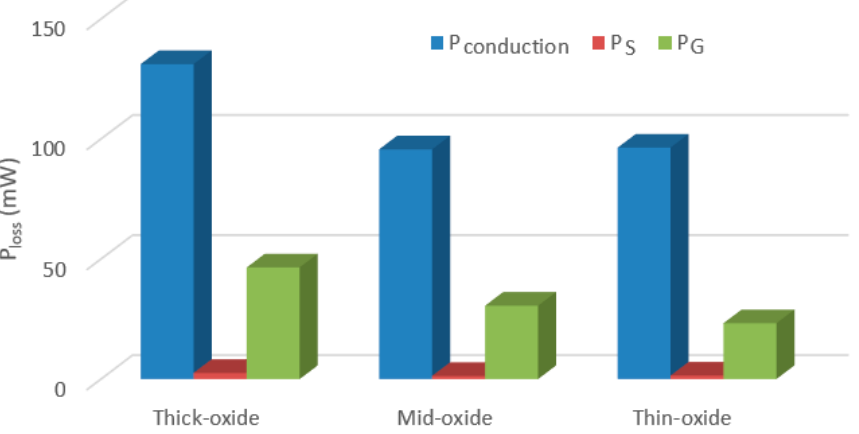
Figure 5. P loss diagram against different oxide thicknesses.